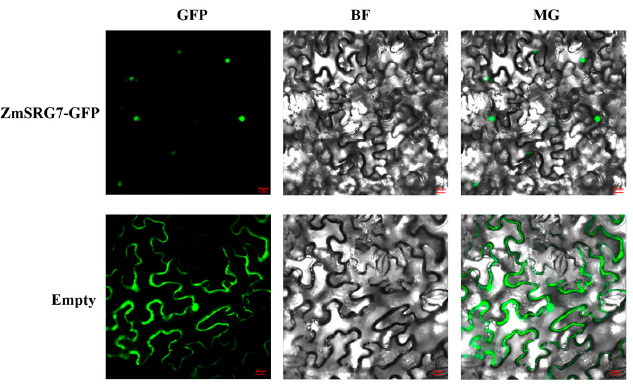
Figure 2. Analysis of ZmSRG7 protein subcellular localization in tobacco cells. The scale bar represents 20 µ m.